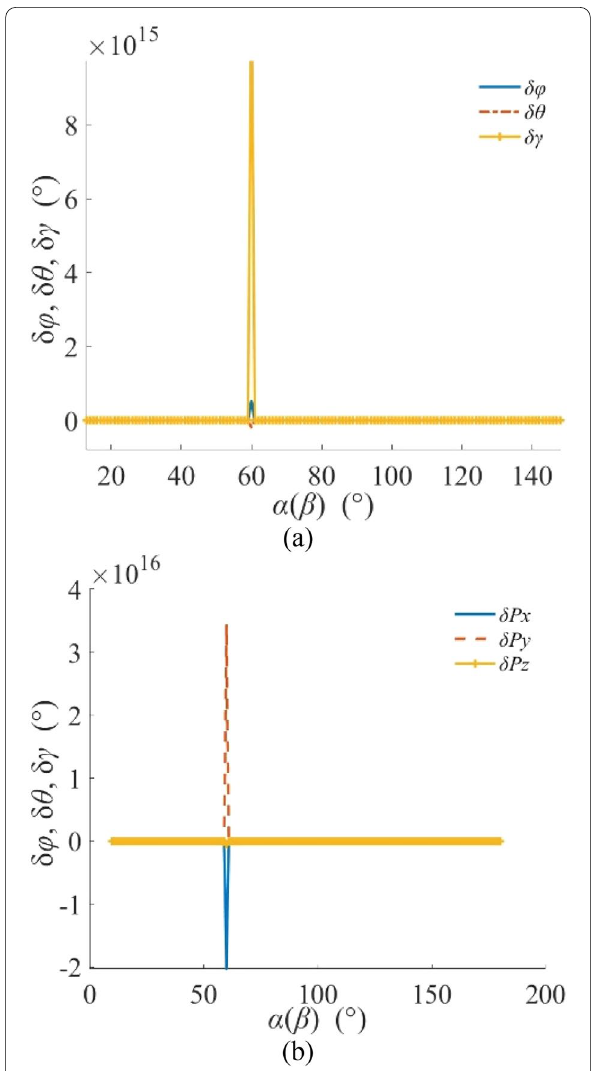
Figure 18 Relation between α ( β ) and output pose errors: a δ P x , δ P y , δ P z to α ( β ), b δ φ , δ θ , δ γ to α ( β )